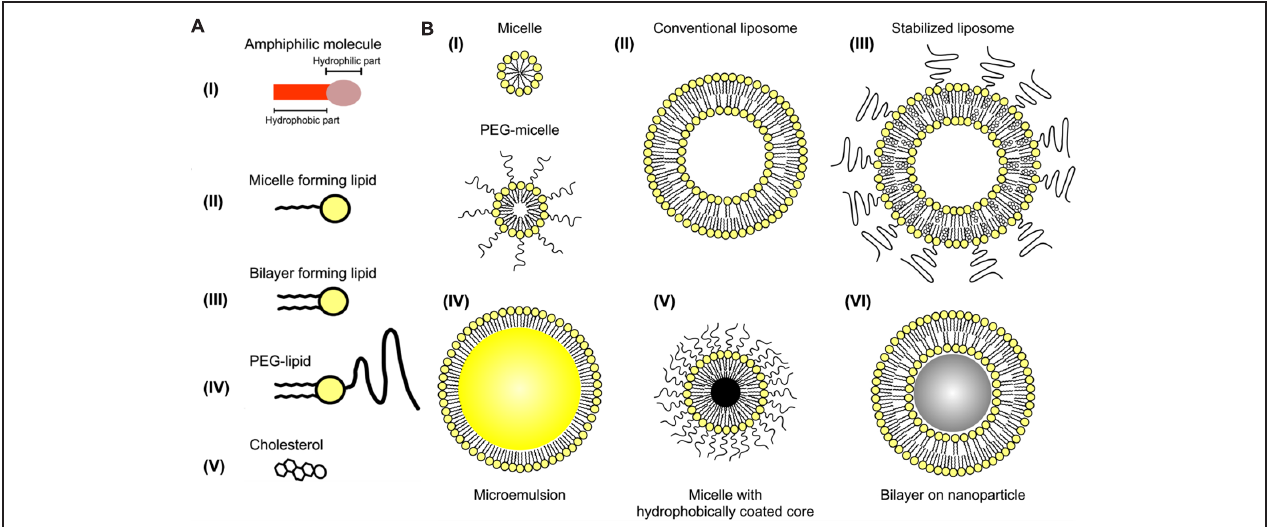
FIGURE 5 | Iodine-containing nanoparticles. (A) Representation of individual amphiphilic lipids that can be incorporated into nanoparticles. (B) Representation of several configurations of self-assembling nanoparticles based on amphiphilic lipids. Iodine can be incorporated into the hydrophobic portion of the micelle, within the non-polar core of an emulsion, or within the aqueous core of liposomes. Reprinted with permission from (Mulder et al., 2006).